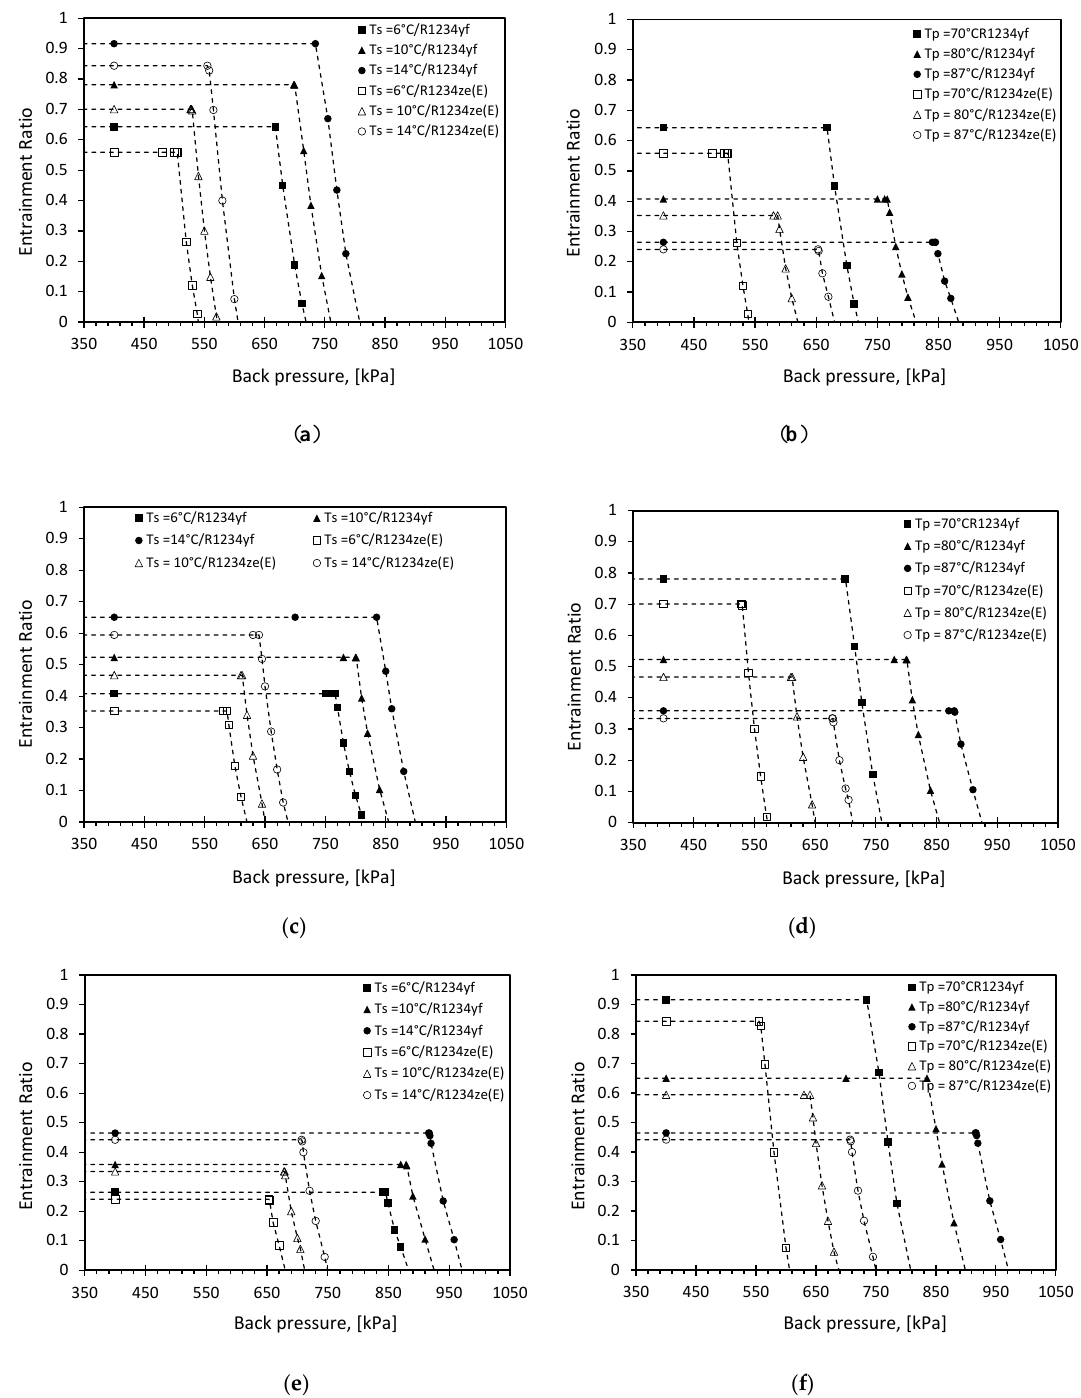
Figure 5. CFD Entrainment ratio vs back pressure for the ejector at different primary and secondary flow temperatures when ( a ) T p = 70°C. ( b ) T s = 6°C. ( c ) T p = 80°C. ( d ) T s = 10°C. ( e ) T p = 87°C. ( f ) T s = 14°C.